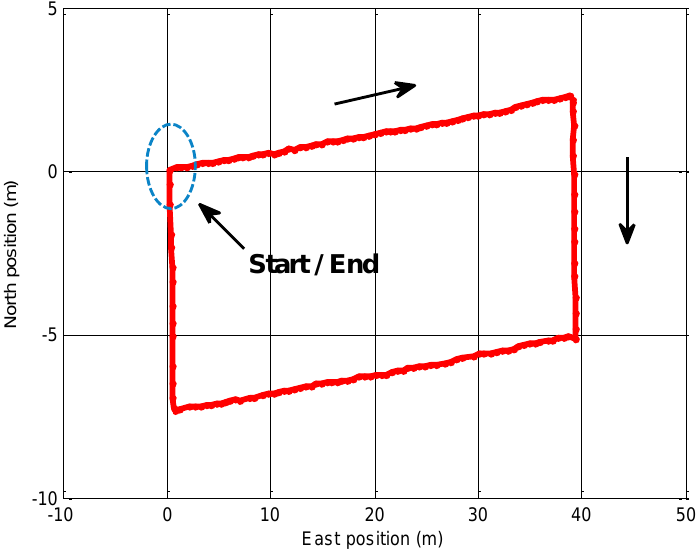
Figure 7. The trajectory of the real experiment